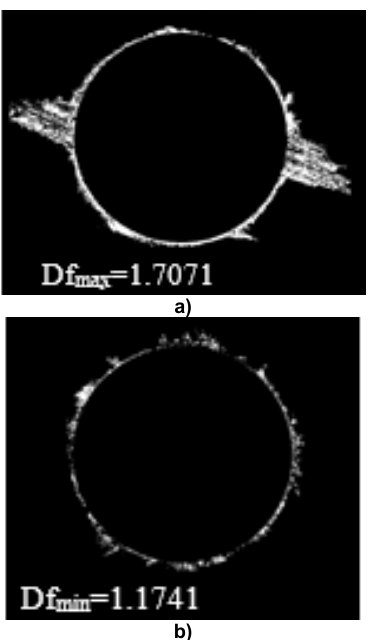
Figure 10. Drilling conditions for the lowest and highest Df and Df images: a) Maximum Df (T2 tool, V = 85m/min, f = 0.2 mm/rev), b) Minimum Df (T1 tool, V = 110 m/min, f = 0.14